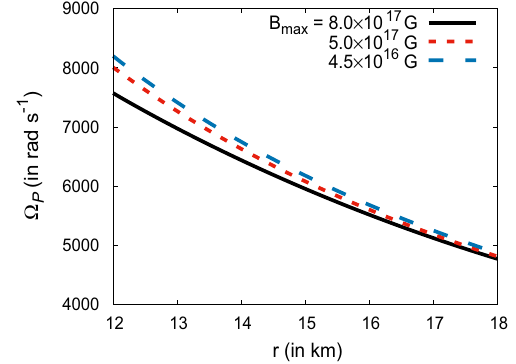
Fig. 22 We have plotted the effect of toroidal magnetic field on Ω P along the equatorial plane. Here we have Ω = Ω g . The black solid curve, the red short dashed curve and the blue dashed curve are for cen- tral magnetic field of 8 . 0 × 10 17 G , 5 . 0 × 10 17 G , 4 . 5 × 10 16 G respec- tively. The central energy density of the NS is taken to be 1 . 0 × 10 15 g